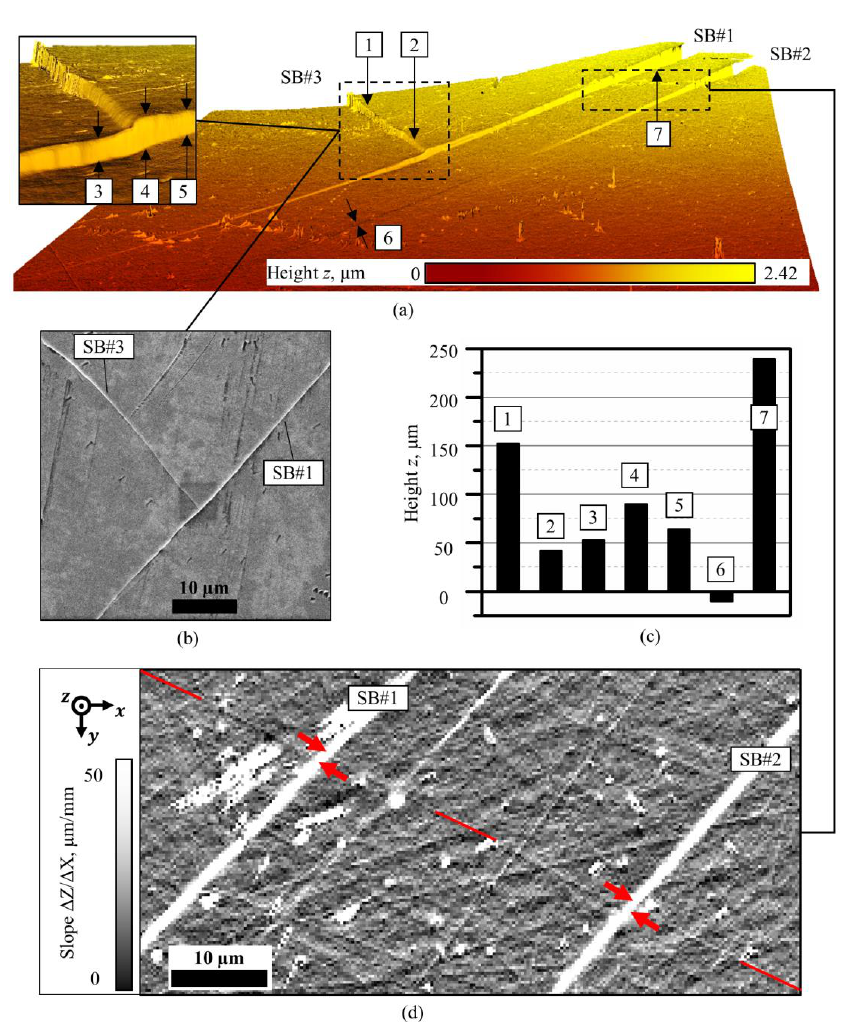
Figure 2. Typical behaviour of primarily mode II shear bands (SBs) in the compressed Pd-based bulk metallic glass (BMG). The 3D surface map (330 × 300 µm 2 ) obtained with the scanning white-light interferometry (SWLI) technique ( a ) shows three SBs (#1, #2, #3) and their topology features. The site of the collision of SB #1 and SB #3 is shown on the inset ( a ) and obtained with scanning electron microscopy (SEM) ( b ) for comparison. Shear steps No. 1 to 7 heights, measured by SWLI and pointed on ( a ) are represented on the bar chart ( c ). The slope map reveals the breaks in the fine scratch (marked with red arrows) by witnessing the mode II shear ( d